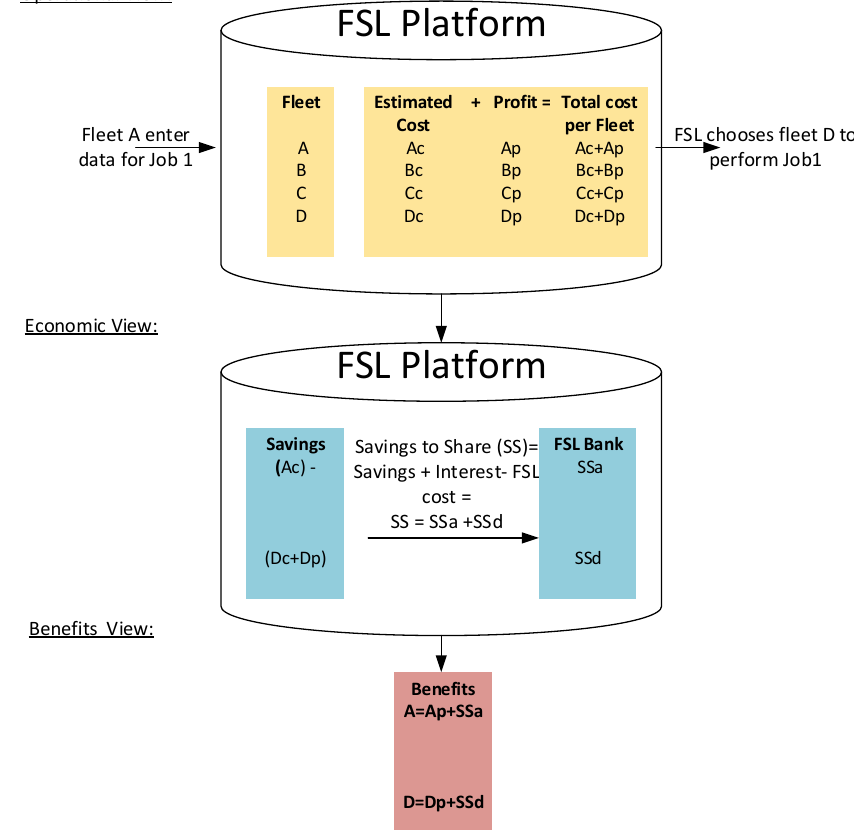
Figure 10. Schematic representation of operational, economic and benefits view for the Freight Share Lab (FSL) platform.